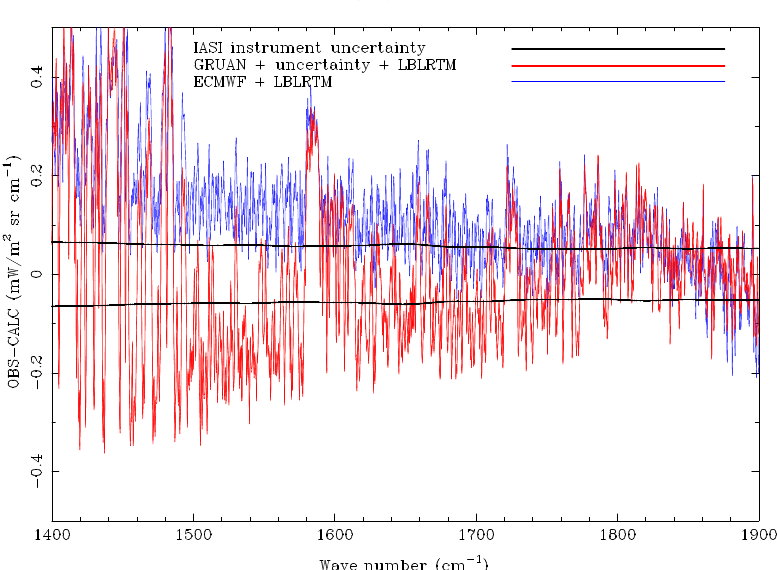
Figure 4. IASI observed minus calculated radiances (OBS − CALC) for a sample sonde (28 July 2011 11:51:33Z). Calculated radiances derived from LBLRTM and GRUAN sondes (red) and ECMWF (blue). IASI overall instrument uncertainty (black). The thickness of the red line (hardly noticeable) denotes the GRUAN uncertainty propagated into radiance space assuming no uncertainty correlation between